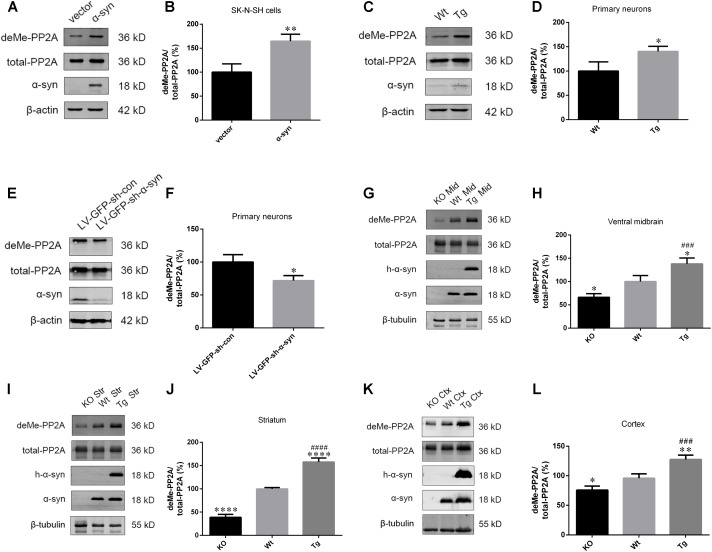
α-syn regulated PP2A demethylation at Leu309 in vitro and in vivo. (A,B) Immunoblot results and quantifications of demethylated PP2A (deMe-PP2A), total-PP2A, and α-syn levels in SK-N-SH cells transfected with pCMV-Myc or pCMV-Myc-α-syn for 24 h. The ratio of deMe-PP2A to total-PP2A in vector group was considered as 100%. (C,D) Immunoblot results and quantifications of deMe-PP2A, total-PP2A, and α-syn in Wt and Tg neuron lysates. The ratio of deMe-PP2A to total-PP2A in Wt group was considered as 100%. (E,F) Immunoblot results and quantifications of deMe-PP2A, total-PP2A, and α-syn in rat primary neurons infected with LV-GFP-sh-con or LV-GFP-sh-α-syn vectors. The ratio of deMe-PP2A to total-PP2A in LV-GFP-sh-con group was considered as 100%. (G–L) Immunoblot results and quantifications of deMe-PP2A, total-PP2A, human α-syn (h-α-syn) and α-syn in brain homogenates from α-syn KO, Wt and α-syn Tg mice. β-tubulin was used as a loading control. The ratio of deMe-PP2A to total-PP2A in Wt group was considered as 100%. Data are expressed as mean ± SD. KS test; P > 0.05; In A–F: F-test; P > 0.05; unpaired Student’s t-test; ∗P < 0.05 vs. vector or LV-GFP-sh-con (n = 3); In G–L: Brown–Forsythe test; P > 0.05; one-way analysis of variance; ∗P < 0.05, ∗∗P < 0.01, ∗∗∗∗P < 0.0001 vs. Wt mice (n = 3); ###P < 0.001, ####P < 0.0001 vs. KO mice (n = 3).